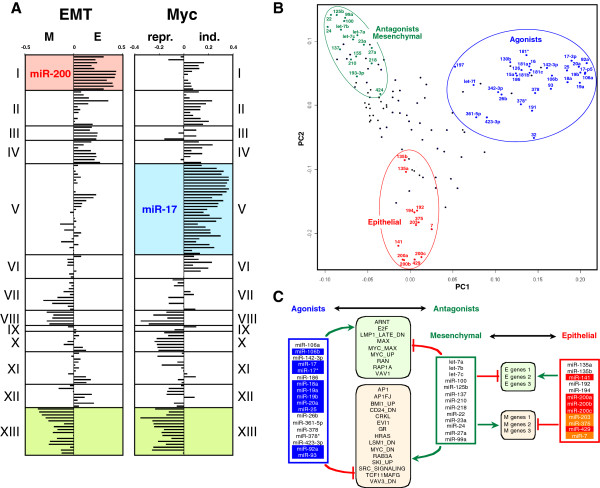
Identification of antagonistic miRNA clusters using the NCI60 data sets. (A) Correlation of gene signatures with 136 miRNAs grouped into 13 miRNAs clusters according to their positively correlating genes as recently described [4]. Left panel, average EMT gene signature (see Methods). M, mesenchymal genes; E, epithelial genes. Right panel, c-Myc-repressed (repr.) and c-Myc-induced (ind.) genes. Three clusters that had highly significant correlations in the Wilcoxon rank analysis (p < 10-7) are highlighted in different colors. The X-axis displays a factor that indicates the level of correlation with the gene sets as explained in the Method section. (B) PCA (Principal Component Analysis) of the 136 miRNAs in A. The miRNAs identified in the three clusters are circled in similar colors as in A. (C) Correlation network based on miRNA groups and gene signatures (E genes, M genes, and oncogenic signatures). Only correlations that were found in the analysis of positively and negatively correlating genes are shown (see Additional file 4: Table S4 and Additional file 6: Table S5). Red box, epithelial; blue box, agonistic; green box, mesenchymal and antagonistic. miRNAs: red, miR-200 family; blue, miR-17 family; orange, other EMT-related miRNAs recently identified [4] (miR-7, miR-203, and miR-375). EMT genes: light green box, E genes; light red box, M genes. Oncogenic signatures: light green, positively correlated with agonistic miRNAs; light red, negatively correlated with agonistic miRNAs. Epithelial specific miRNAs are highlighted in red and members of the miR-17 family of miRNAs are highlighted in blue.